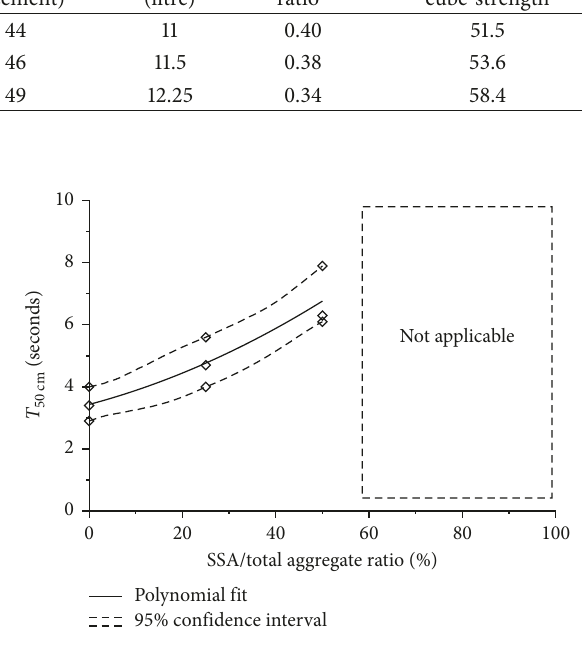
Figure 3: Relationship between the SSA replacement ratio and T 50cm in the slump flow test.